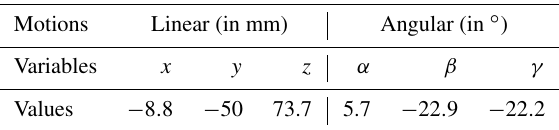
Figure 11. Robotic-assisted bone reduction procedure. From pre- operative to intra-operative surgery. Table 2. Motion variables measured for the repositioning of femur